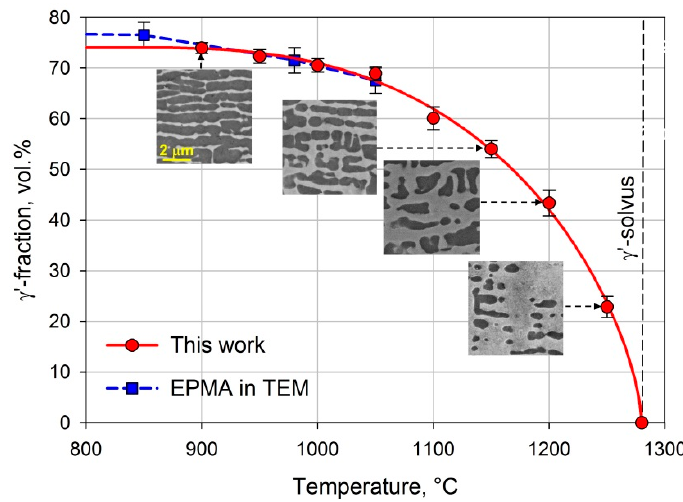
Figure 4. The γ ’-volume fraction in CMSX-4 as a function of temperature. Blue squares and a blue dashed line—measured by electron probe X-ray microanalysis (EPMA) in transmission electron microscopy (TEM) in [46] (averaged for two deliveries of CMSX-4), and the red circles and red solid line (approximation with Equation (4))—in this work. Inserts are SEM images of the pre-rafted γ / γ ’-microstructures quenched from investigated temperatures. Table 1. The γ ’-volume fraction 𝑓 (cid:2926) as a function of temperature, vol. %. T , °C